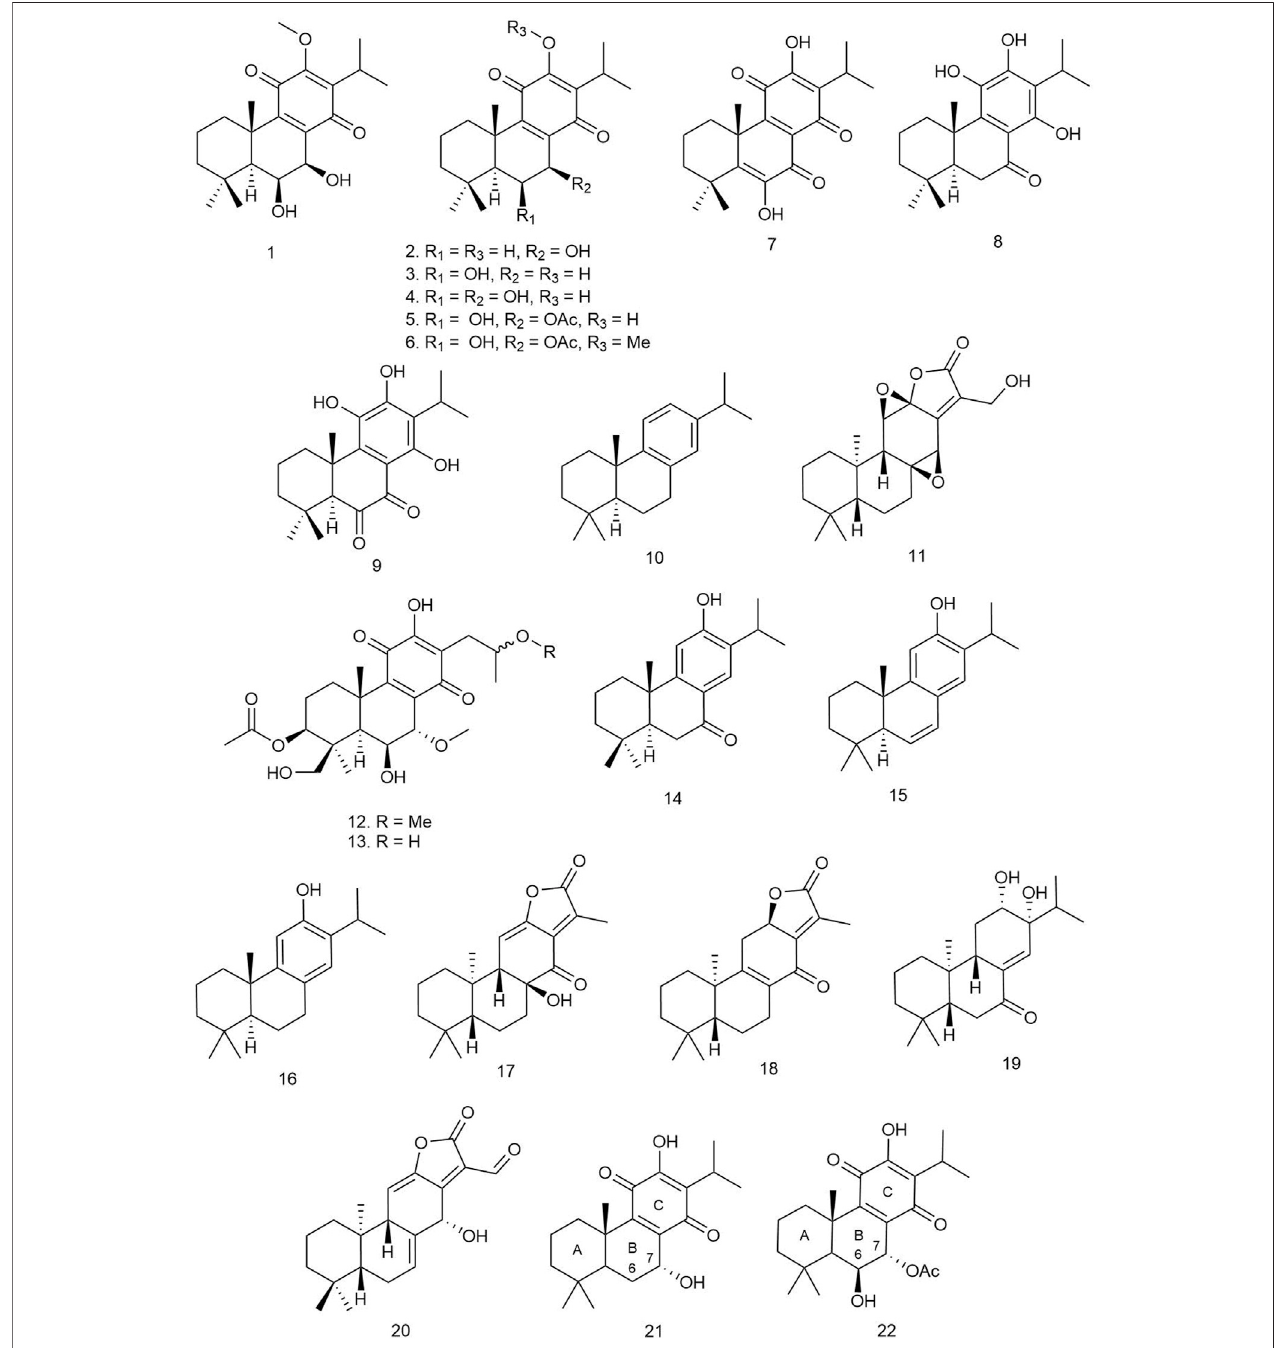
FIGURE 2 | Structures of abietane diterpenoids with signi fi cant antibacterial activity.